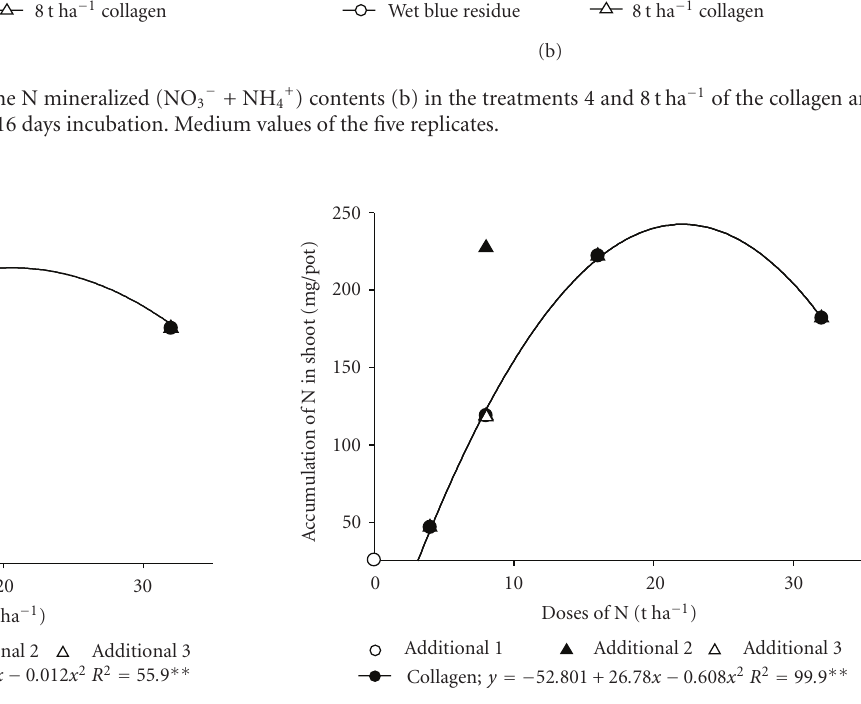
Figure 6: Accumulation of N in the shoot dry matter in bean plants grown for 84 days, under influence of the studied treatments (col- lagen: four rates; additional 1: soil without fertilization and without collagen; additional 2: fertilization with mineral N; additional 3: wet blue